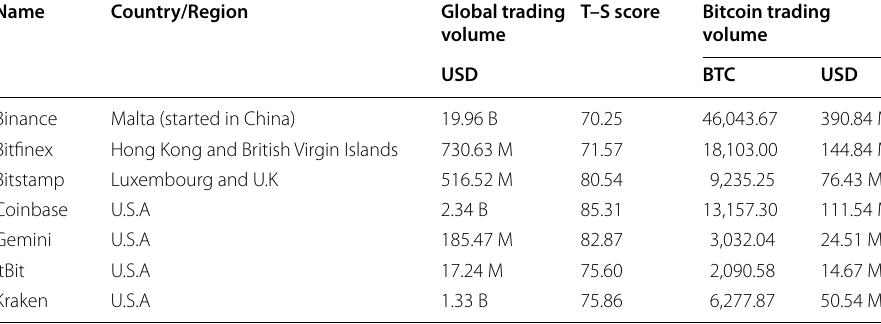
Global trading volume (USD) includes the daily trading volume of all cryptocurrencies in the exchange. Bitcoin trading volume shows mean daily bitcoin trading volume for the period under analysis in BTC and USD. T–S Score shows the score of transparency and security of the